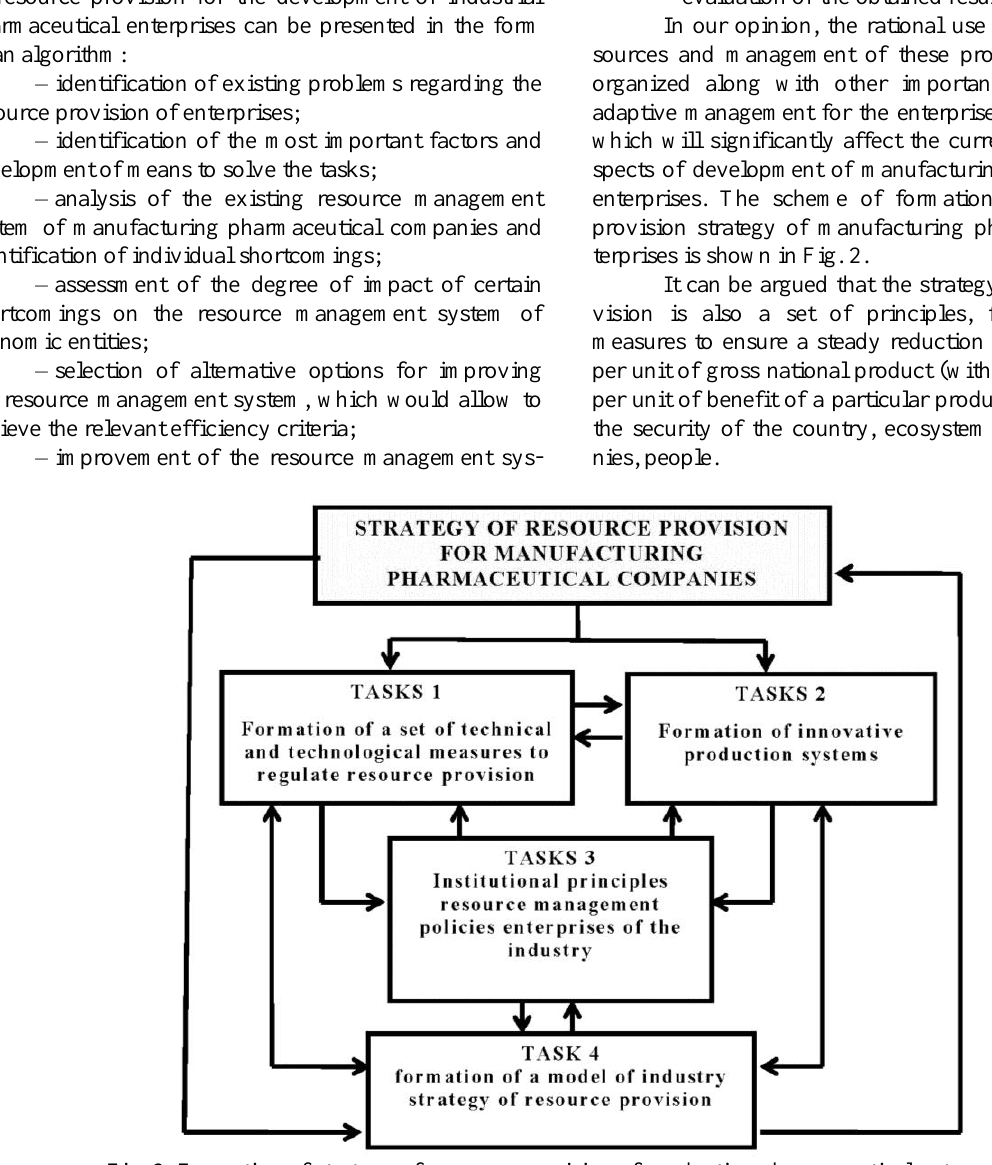
Fig. 2. Formation of strategy of resource provision of production pharmaceutical